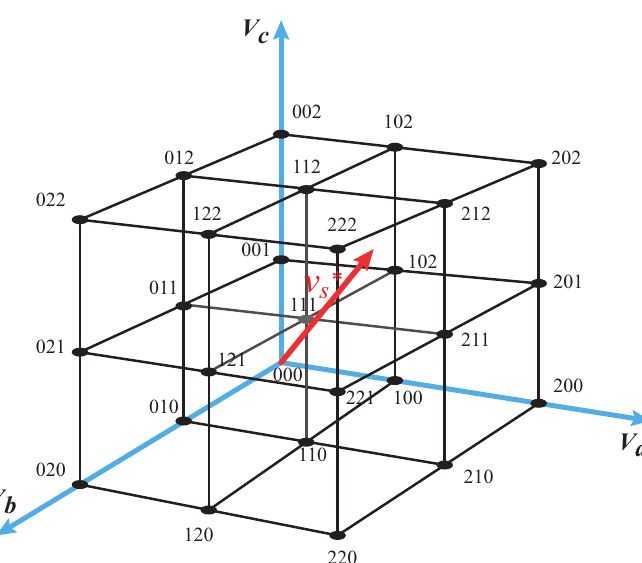
Figure 11. Generalized 3D space for a three-level NPC inverter.